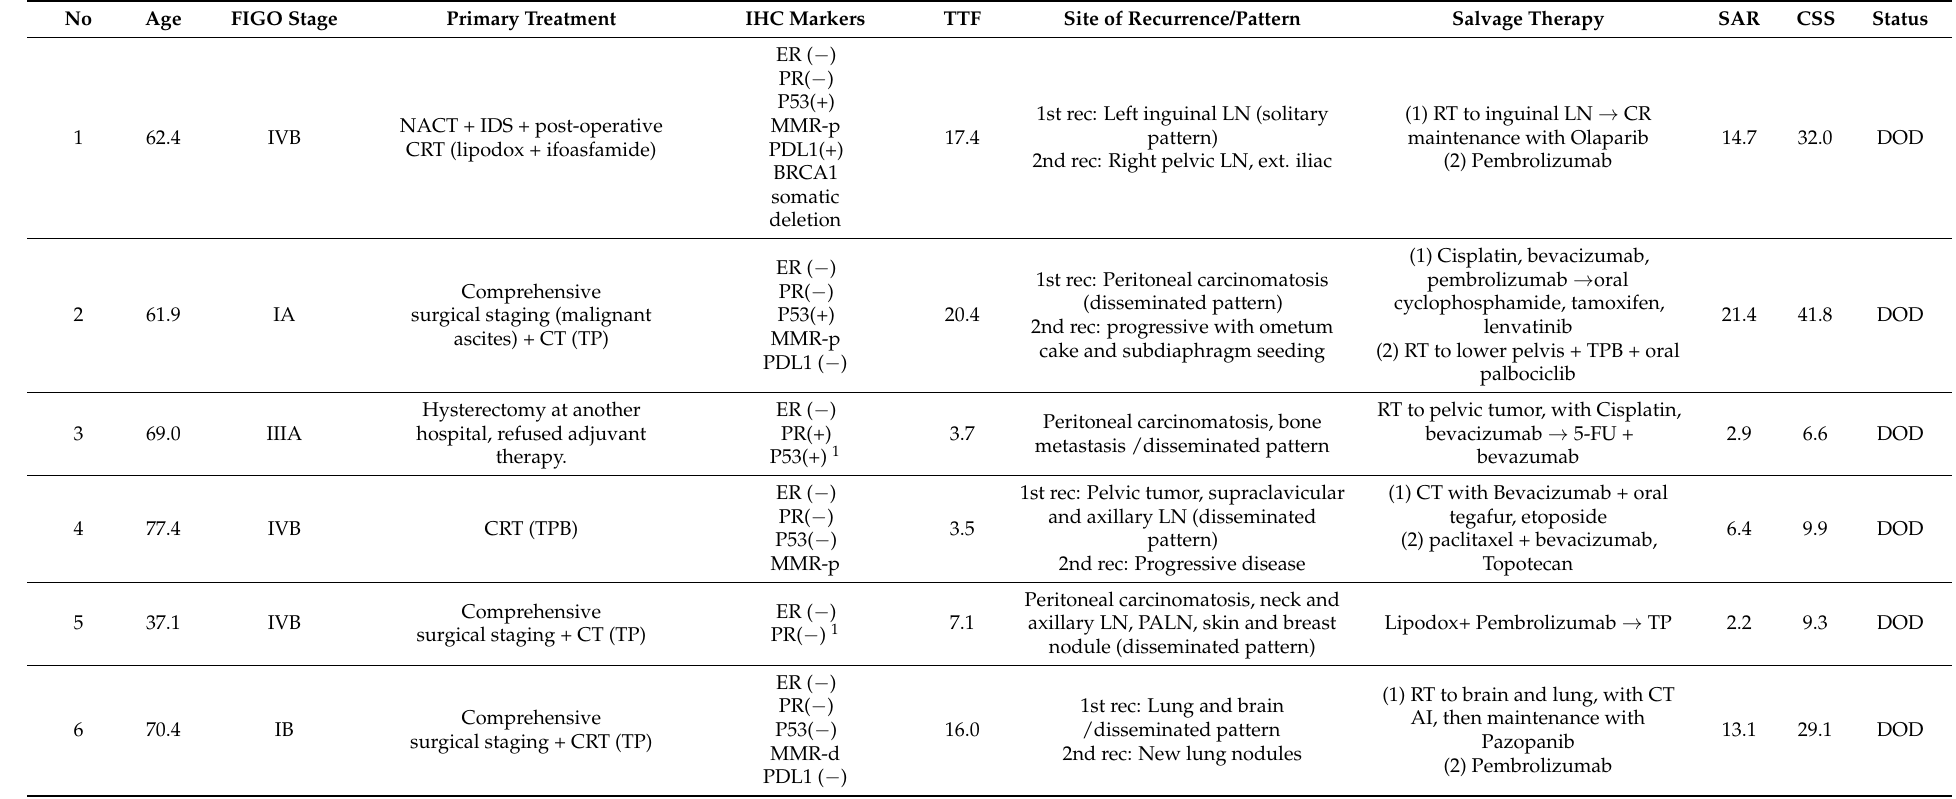
FIGO Stage Primary Treatment IHC Markers TTF Site of Recurrence/Pattern Salvage